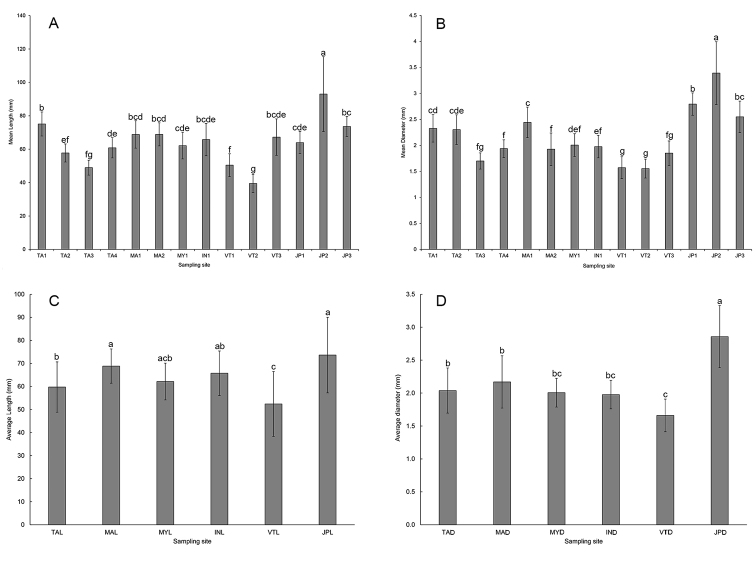
Mean (A, C) length and (B, D) diameter of P.litoralis samples within each (A, B) locality and (C, D) country sampled in this study. Sampling site codes are given in Table 1. Different letters above the bar indicate a significant difference (P < 0.05; one-way ANOVA).